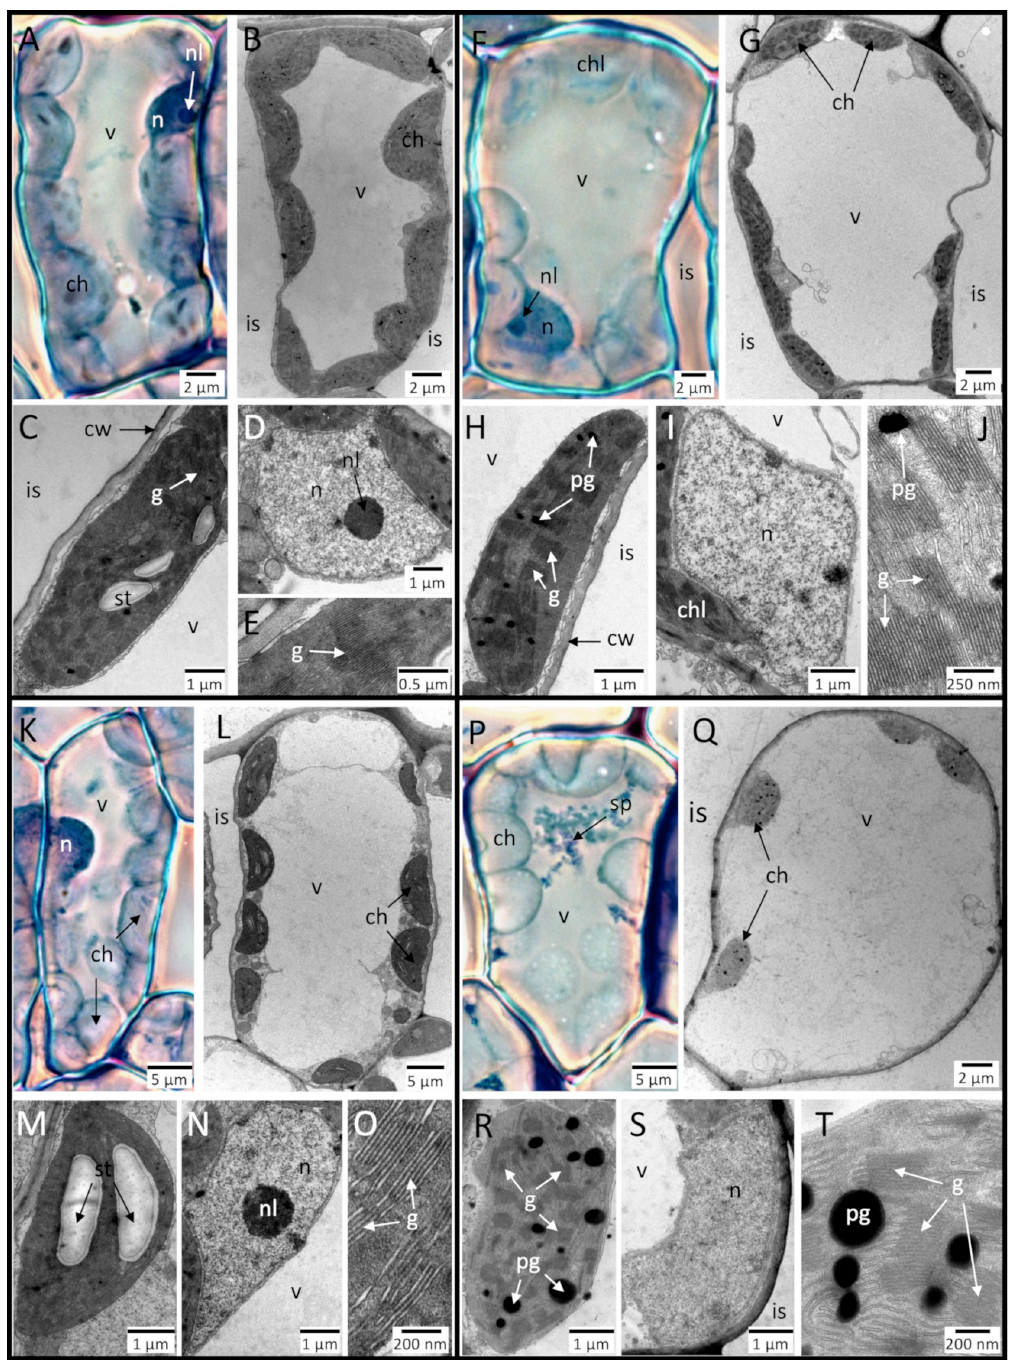
Fig 4. Evolution of degenerative traits at the cellular and subcellular level within mesophyll cells surrounding HR-like lesions inside of hybrid poplar ( Populus tremula x alba ) leaves at the 3 rd leaf position and in response to the CF+100 ppb O 3 (K–O, P– T) treatment relative to the CF treatment (A–E, F–J). Treatment time: 8 days ( A – E, K – O ) or 23 days ( F – J, P – T ). The main difference between the two treatments was the quicker evolution of degenerative traits in the O 3 -treated trees ( F , G ) relative to the CF trees ( P , Q ). Markers at the cellular level: relative increase in vacuole (v) size at the expense of cytoplasm and the apparent reduction in the number and size of chloroplasts (ch). Markers at the subcellular level: within chloroplasts: increase in starch grain (st) accumulation ( K – M vs . A – C ), injury to thylakoid membranes of grana (g; R , T vs . H , J ) and increase in the plastoglobuli (pg) size and frequency ( Q , R , vs . G , H ); within nucleus (n): condensation of chromatin and loss of nucleoli (nl; N , S vs . D , I ); in the vacuole: accumulation of secondary metabolites (sp; P vs . F ). Other structures: cw: cell wall, is: intercellular space. Technical specifications: post-fixation using OsO 4 , contrasting using uranyl acetate and lead citrate, observation in TEM ( B – E , G – J , L – O , Q – T ); staining with Toluidine blue, observation under phase contrast in bright field microscopy ( A , F , K , P ).